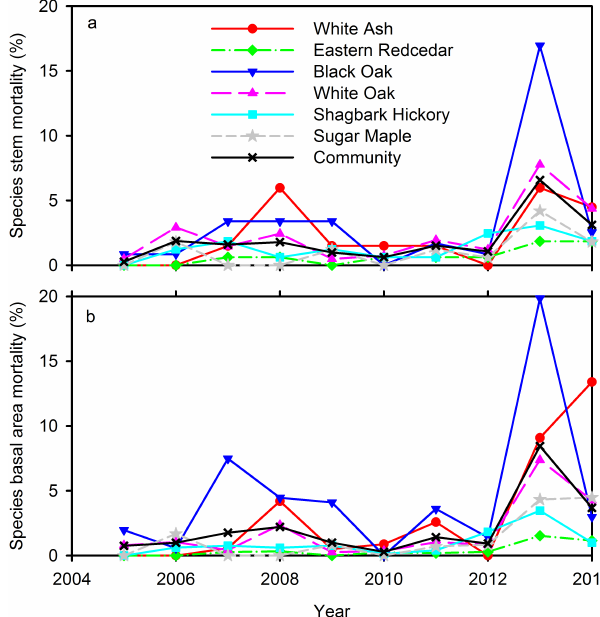
Figure 7. Inter-annual variations in the species mortality expressed relative to either the stem number density (a) or the basal area (b) of a species in